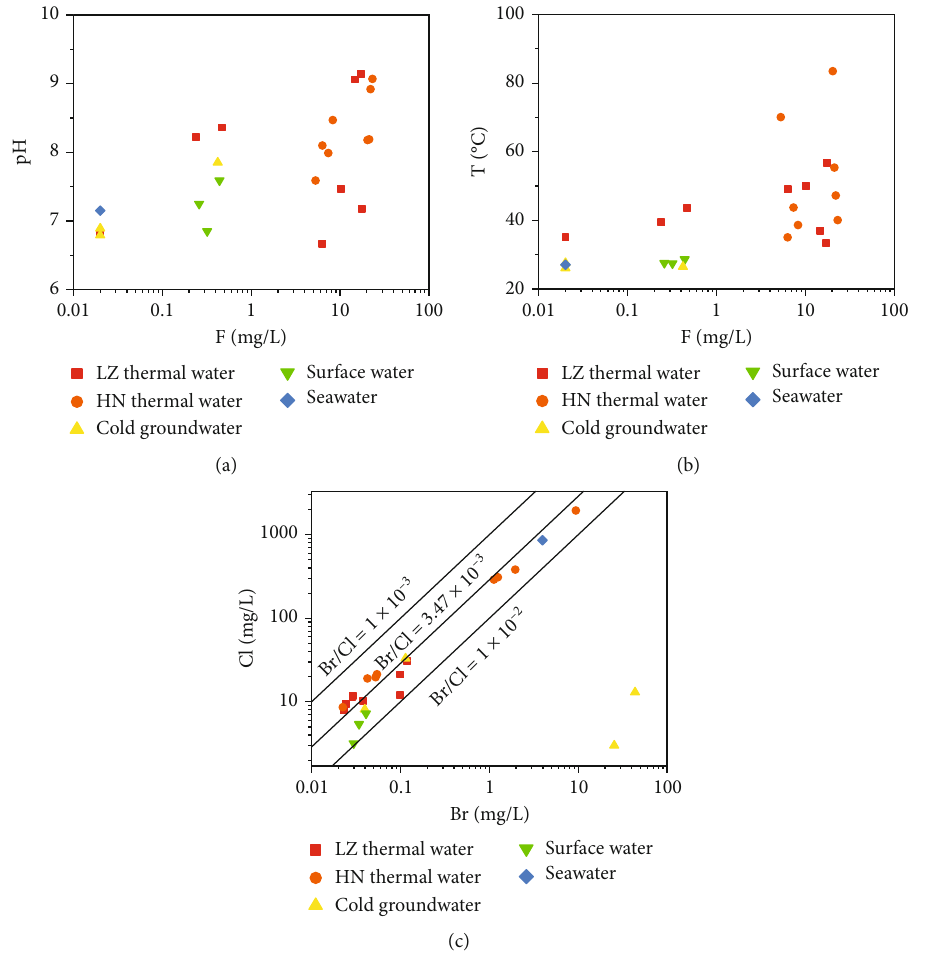
Figure 5: Correlations between F and TDS (a), F and T (b), and Br and Cl(c) for the water samples from LZ and HN